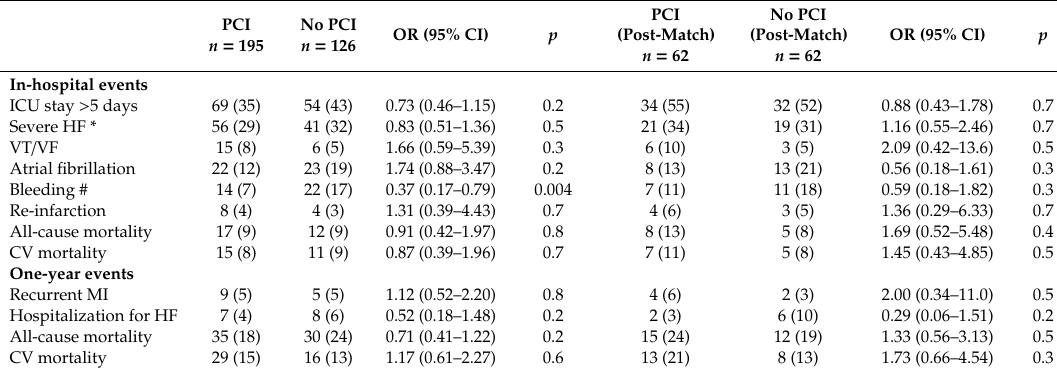
Table 3. Outcomes ( n